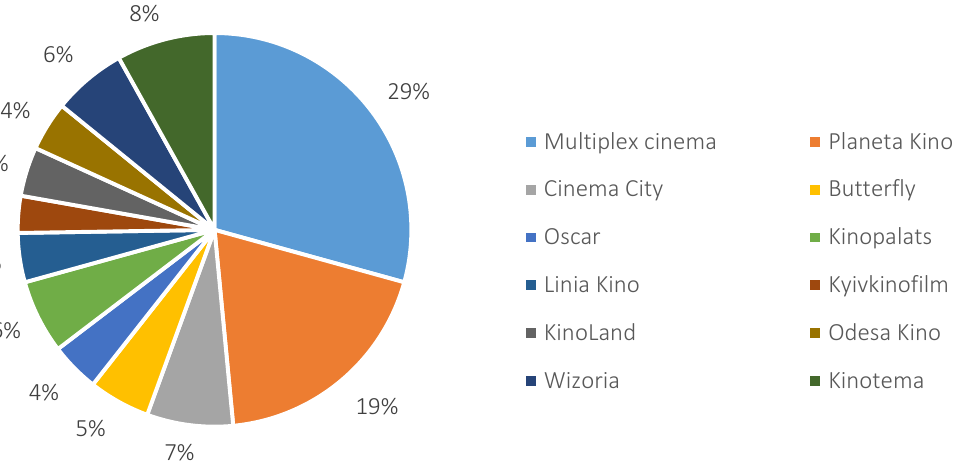
Figure 3. Distribution of cinema chains segments operating in the Ukrainian film market, %